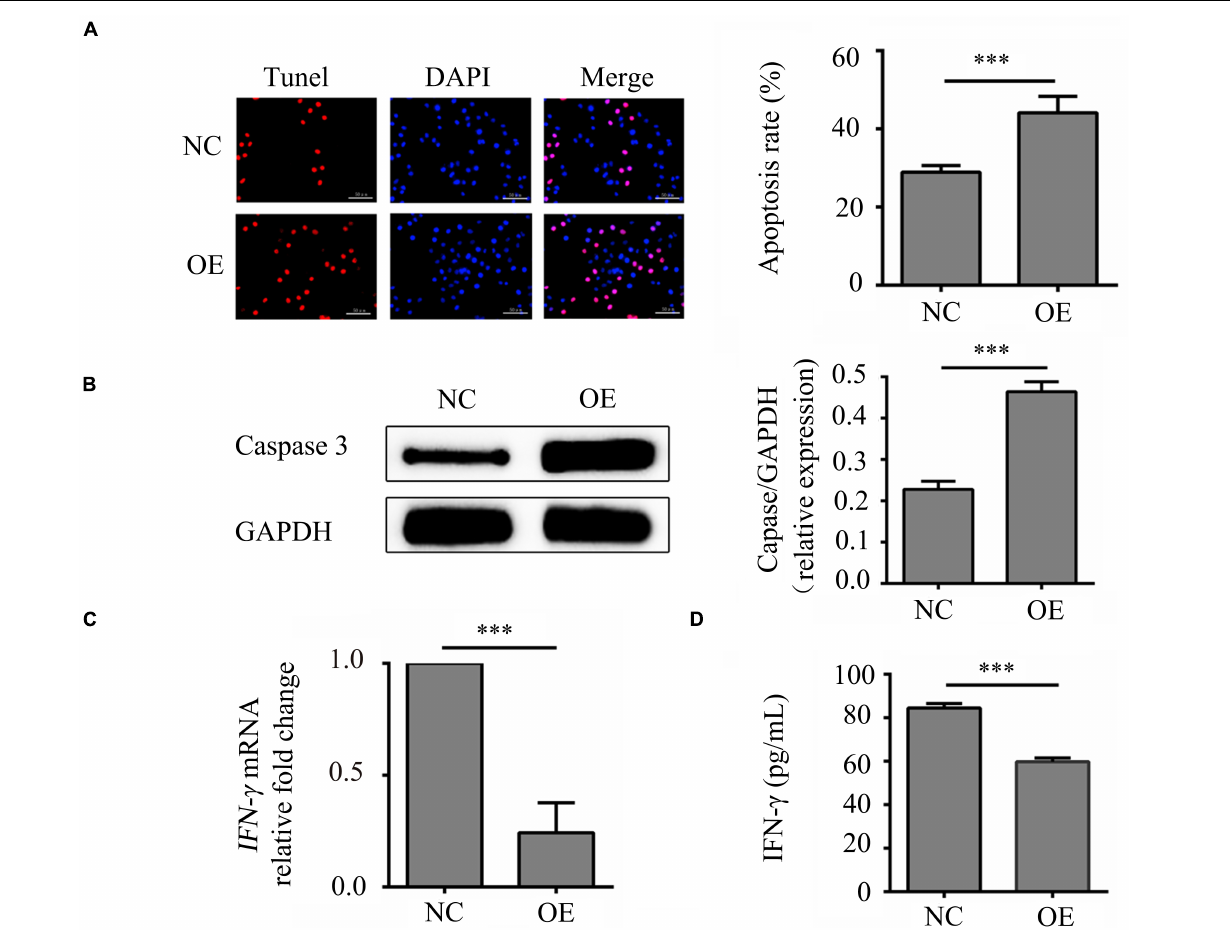
FIGURE 1 | Effects of lncRNA-ENST00000421645 on apoptosis and secretion of IFN- γ in T lymphocytes. (A) Apoptosis was detected in T lymphocytes transfected with empty lentiviral vector (NC cells) and T lymphocytes transfected with lncRNA-ENST00000421645 overexpression lentiviral vector (OE cells) with a TUNEL apoptosis detection kit. (B) The protein level of caspase3 in NC cells and OE cells was determined by Western blot analysis. (C) The relative fold change in IFN- γ mRNA expression in NC cells and OE cells was determined by RT-qPCR. (D) The IFN- γ protein concentration in NC cells and OE cells was measured by ELISA ( ∗∗∗ P < 0.001). Student’s t -test was used for comparisons between two groups. Two-tailed P- values less than 0.05 were considered statistically